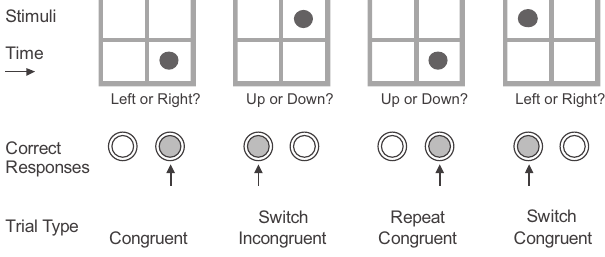
Figure 2. Stimulus paradigm. Correct responses and trial-types for three successive trials of one of the two cued